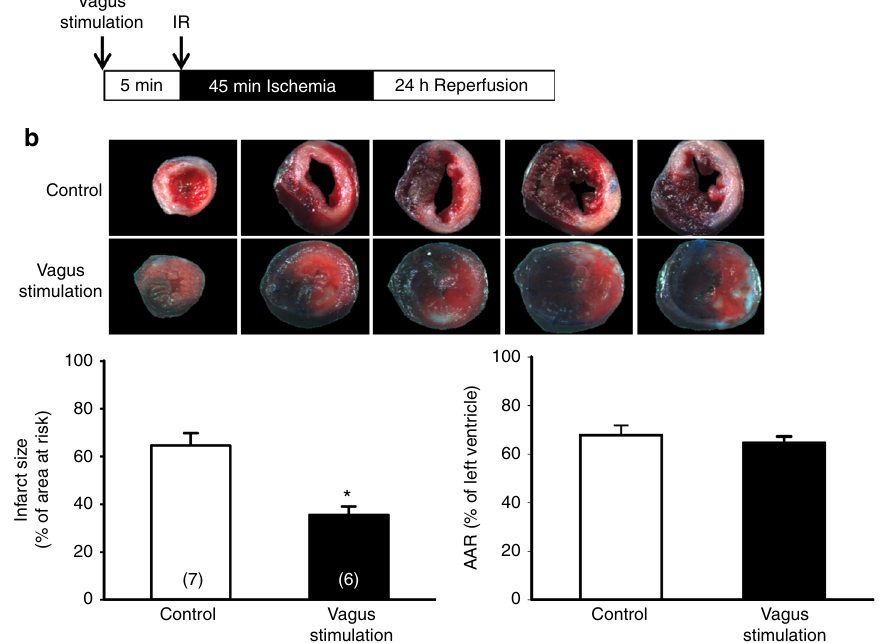
Fig. 10 Direct stimulation of vagus nerve protects heart from IR injury. a Schematic of experimental design showing the timeline for vagus nerve stimulation (5 min) and IR injury (immediately after vagus nerve stimulation). b Representative images of TTC staining in heart cross-sections. Quanti fi cation results of infarct size and AAR in cardiac sections from vagus stimulation and control groups. Activation of vagus nerve provides cardioprotection. * p < 0.05 vs. control group. Error bars indicate SEM. Statistical signi fi cance was determined by Student ’ s t- test ( b